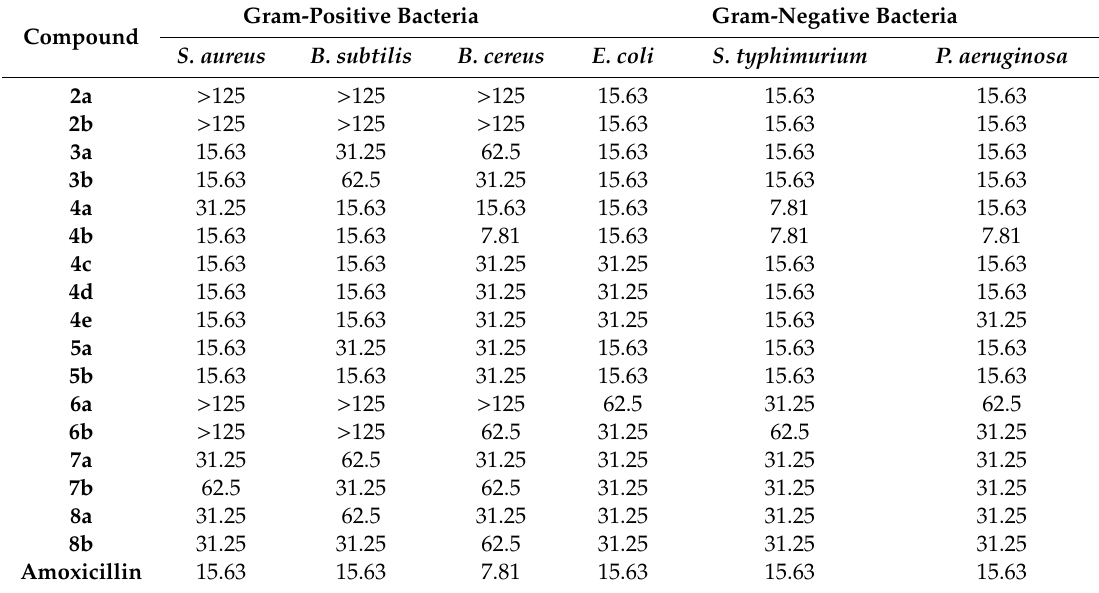
Table 1. Minimum Inhibitory Concentration (MIC) values in µ g / mL of all the target compounds against di ff erent bacterial